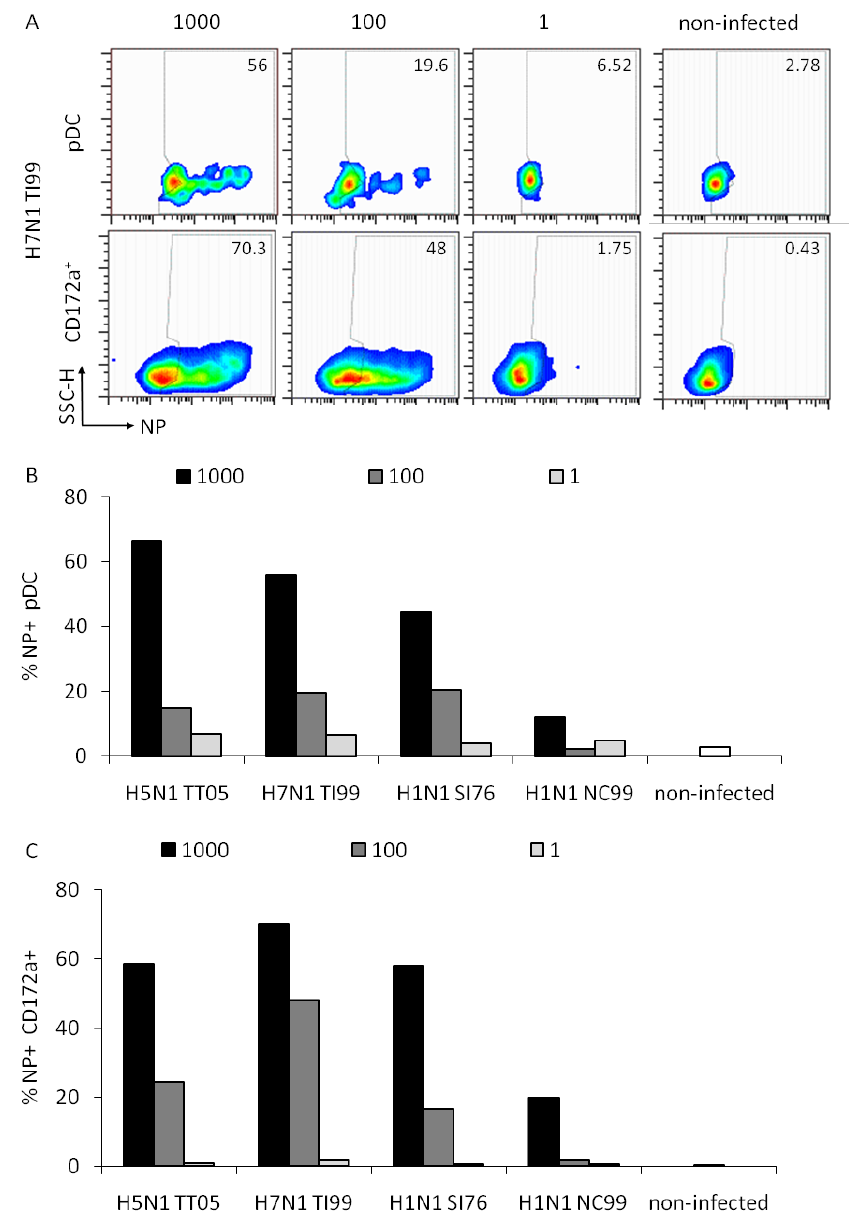
Figure 4. Relation between virus dose and cell infection. Porcine pDC were plated in 12-well plates and infected as in Figure 3 at 1000, 100 and 1 HAU dose or left non-infected at 37 °C. Cells were harvested, fixed and labeled for NP expression after 6 h. Cells were gated as exemplified in Figure 3 to differentiate the pDC and entire CD172a + monocytic/DC population. ( A ) Side scatter/NP pseudo-color dot plots of pDC (upper panels) or the entire CD172a + cells (lower panels) are shown for H7N1 TI99 infection at the three tested doses as well as for non-infected cells. Numbers in the plots indicate the percentage of NP positive cells for both populations. ( B ) Percentage of NP positive pDC in function of the virus dose. ( C ) Percentage of NP positive CD172a + cells in dependence of the virus